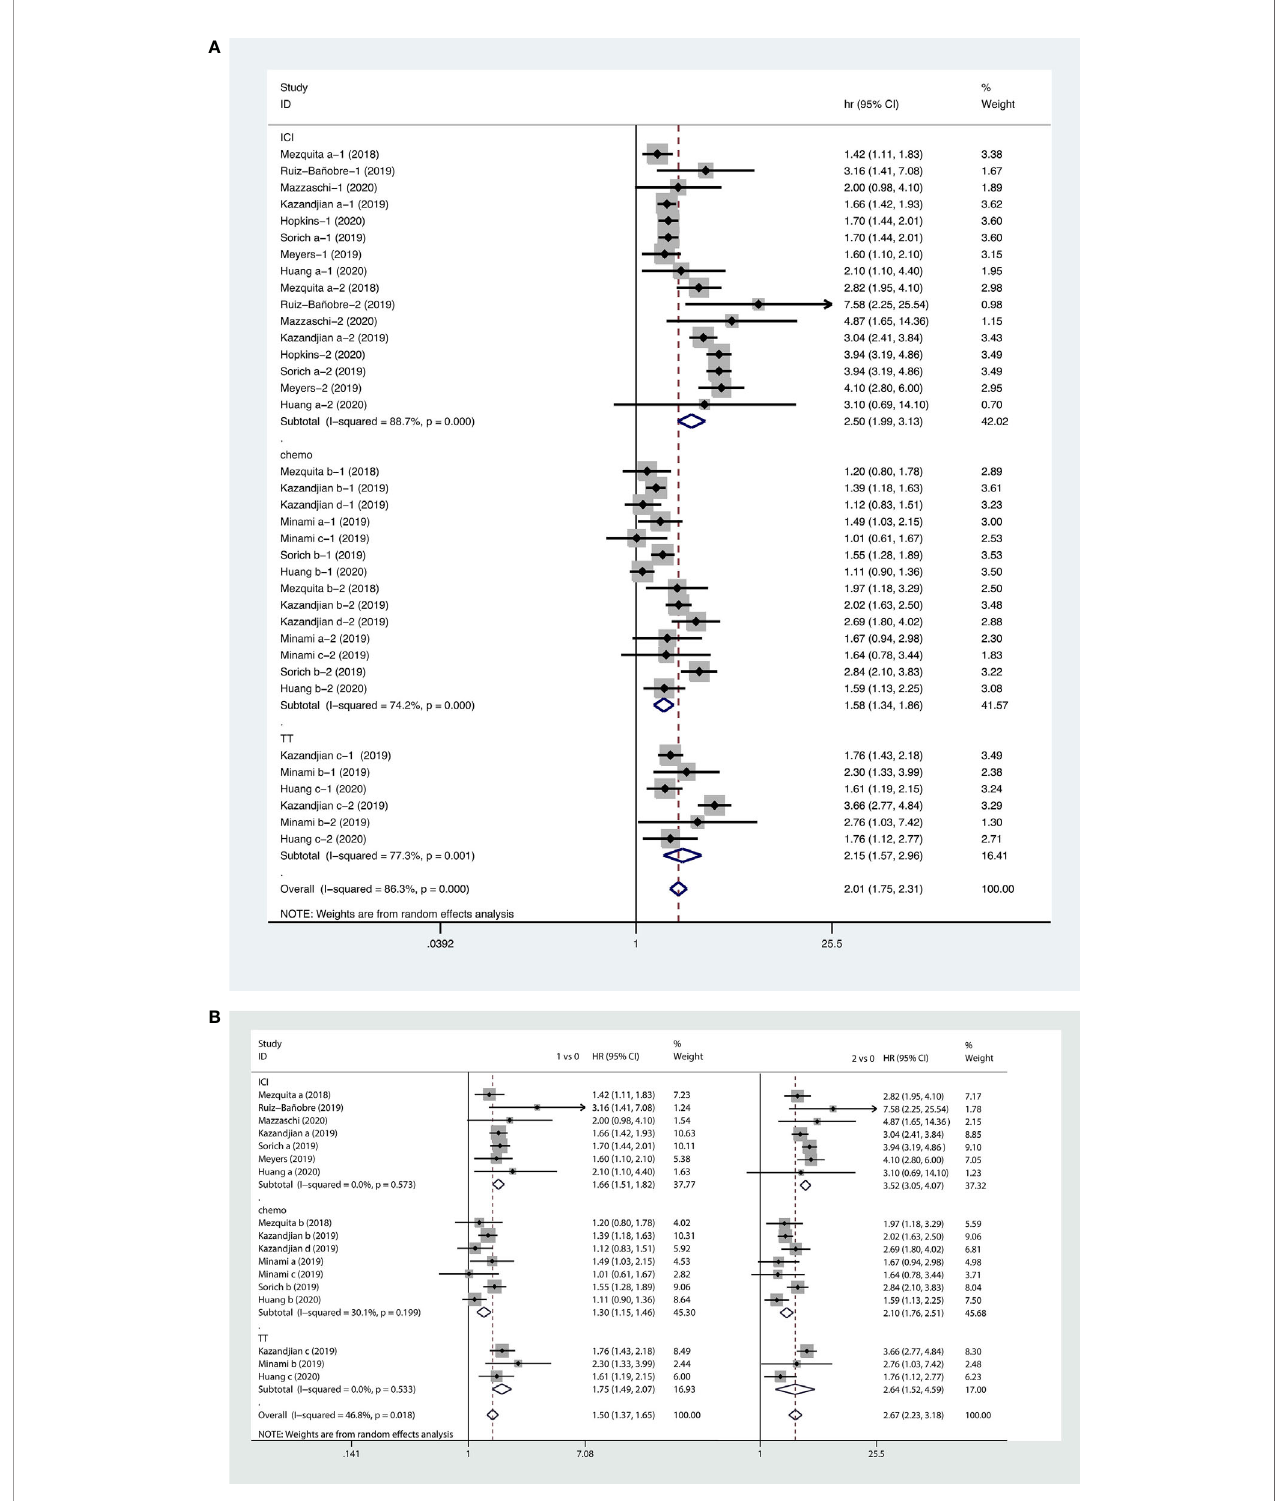
FIGURE 5 | Forest plots of pooled studies examining associations between the lung immune prognostic index (LIPI) score for overall survival (OS), with subgroup analyses categorized by treatment region (A) and LIPI scores (B) ; HR, hazard ratio; CI, con fi dence interval; LIPI score of 1 vs. 0: intermediate versus good; LIPI score of 2 vs. 0: poor versus